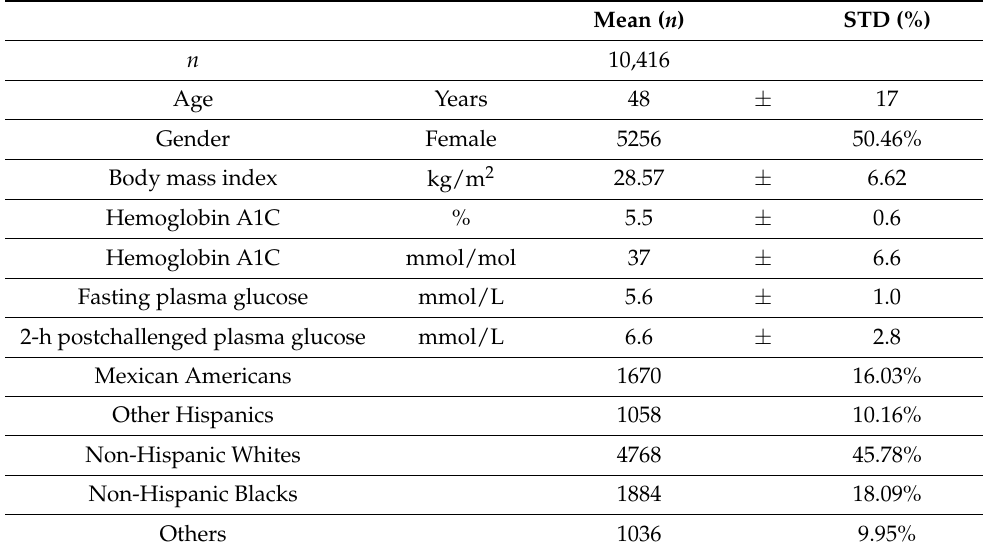
Table 1. Clinical characteristics of the studied subjects without a prior diagnosis of